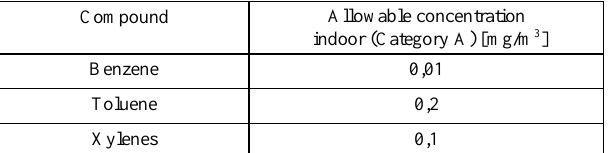
Table 1. Allowable concentration of indoor substances, category A [1]